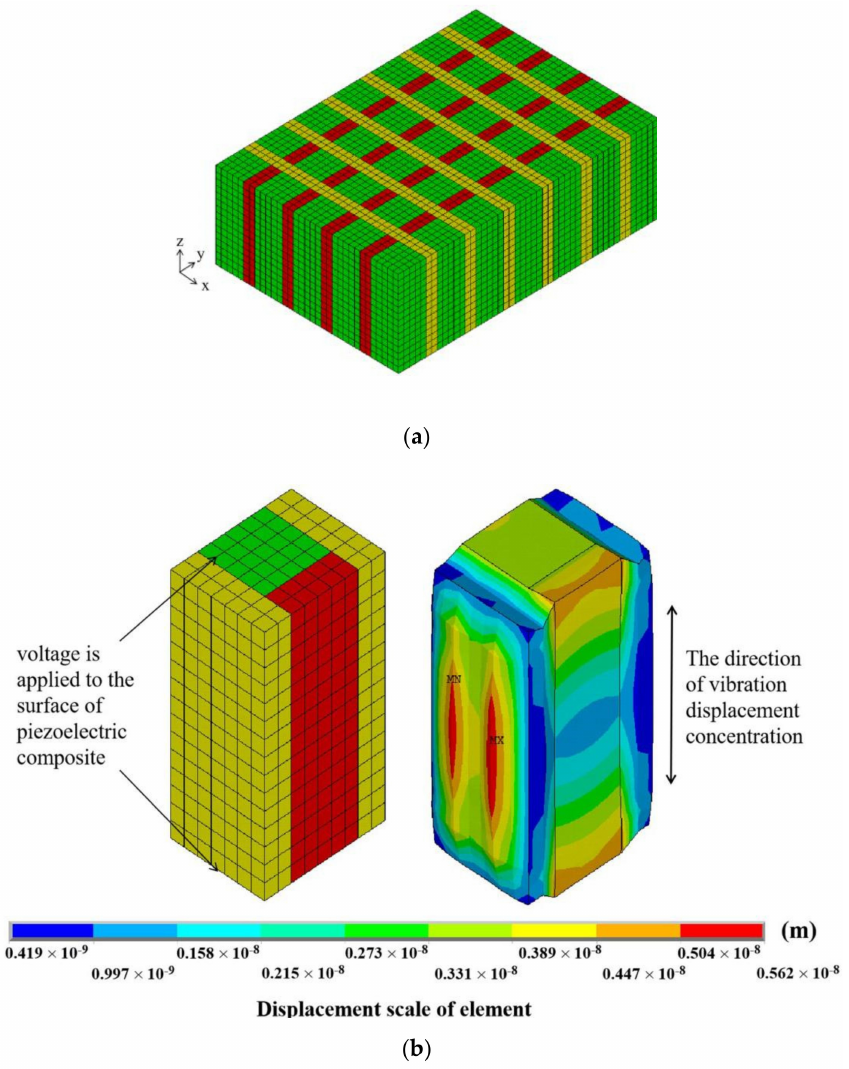
Figure 2. Mesh division of finite element analysis ( a ) and its element vibration displacement ( b